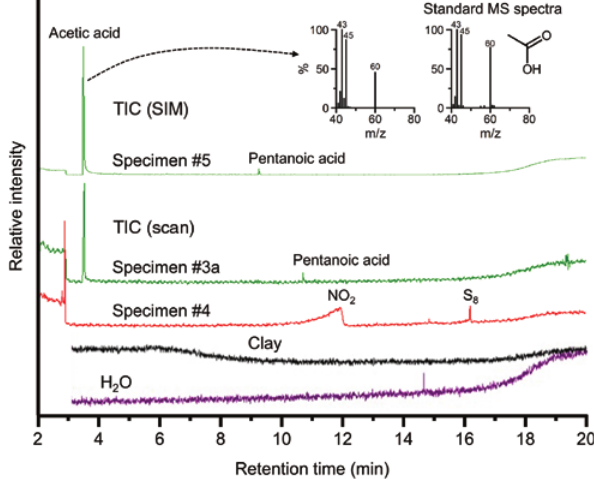
Figure 4: GCMS spectra of specimens 3a, 4, and 5. The spectra of